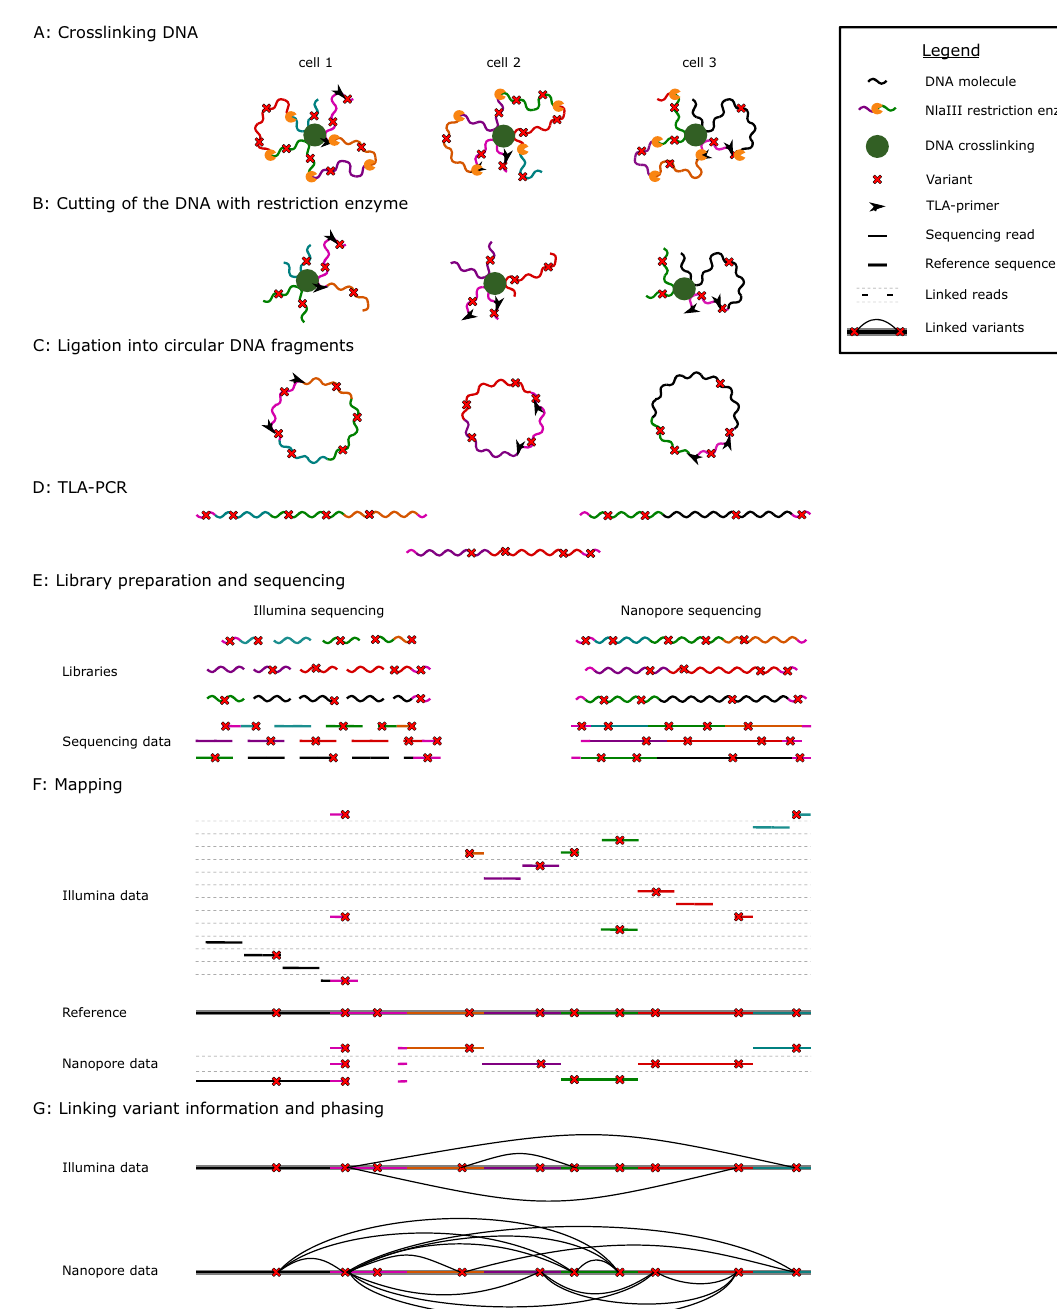
Figure 1. Overview of the TLA workflow performed in this study. ( A ): First, the DNA of each cell was crosslinked; ( B ): Then, the DNA was digested with the NlaIII restriction enzyme; ( C ): Next, the restricted DNA fragments were ligated into circular DNA, and circular DNA strands were reverse crosslinked; ( D ): A TLA-PCR was performed using the designed primers, resulting in linear DNA; ( E ): The DNA was split into two pools, one for Illumina sequencing and one for Nanopore sequencing. On each pool, corresponding library preparations and sequencing were performed. ( F ): Illumina and Nanopore sequencing data were mapped on the GRCh38 reference genome; ( G ): After variant calling, the link information in the sequencing data was used to link the different variants enabling a more detailed